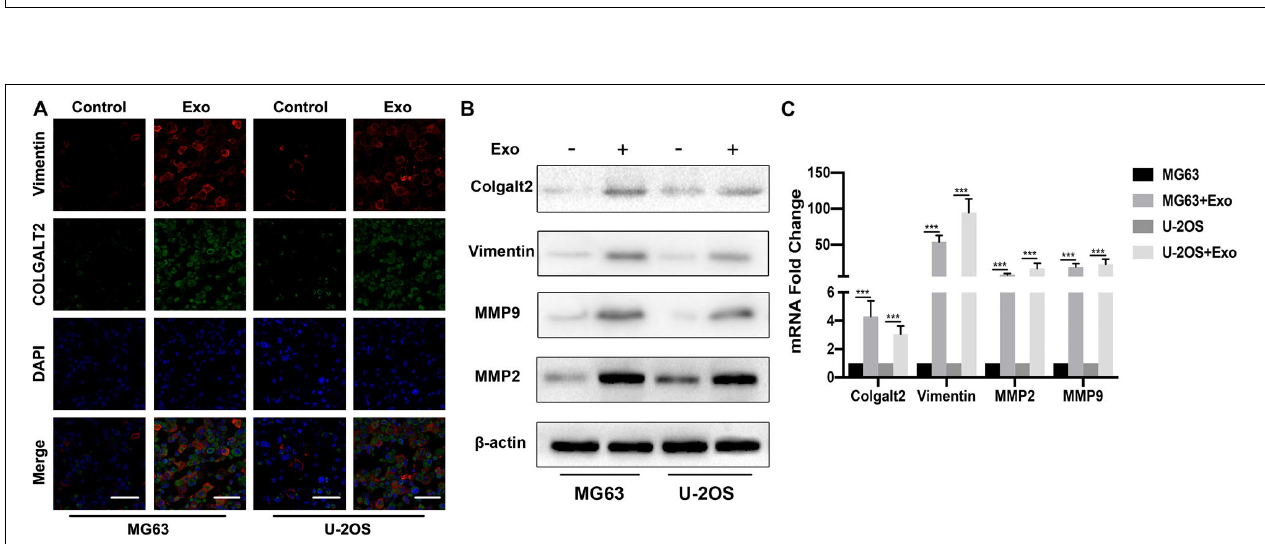
FIGURE 2 | ADSC exosomes foster the invasion, migration, and proliferation of osteosarcoma cells. (A) The effects of ADSC exosomes on osteosarcoma cell proliferation were assessed by a CCK8 assay. Osteosarcoma cells were treated with ADSC exosomes, and the optical densities of the two groups were measured at 450 nm. Data collected from the three respective experiments are displayed. (B) Statistical analysis of colony numbers and representative images of colony formation are shown. (C) Wound-healing assay comparing the motility of osteosarcoma cells treated with or without ADSC exosomes. (D) Comparison of osteosarcoma cell invasion after treatment with or without ADSC exosomes using Transwell compartments. The statistical analysis of the number of penetrated cells is shown in the right panel. *** P < 0.001.